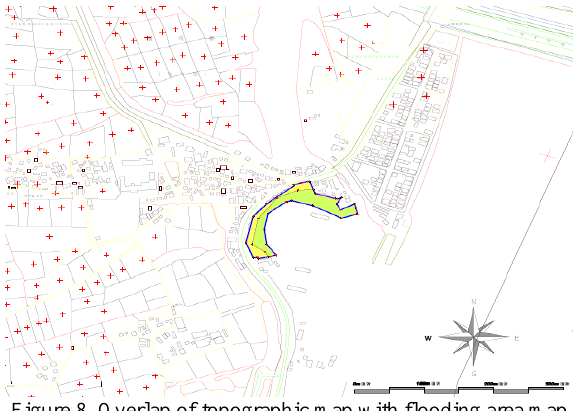
Figure 8. Overlap of topographic map with flooding area map